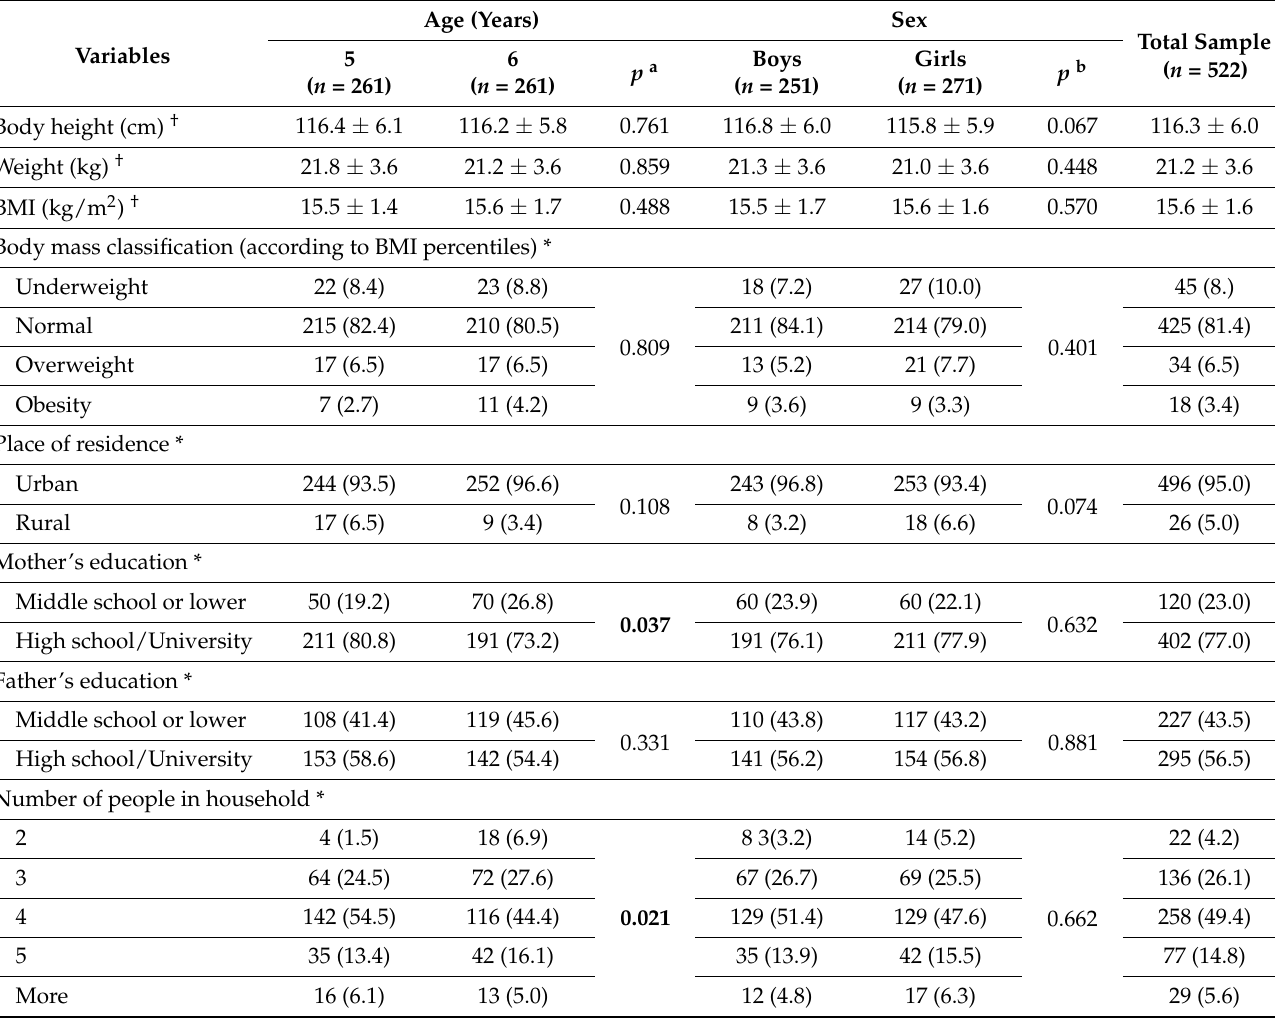
Table 1. Characteristics of the population by age and